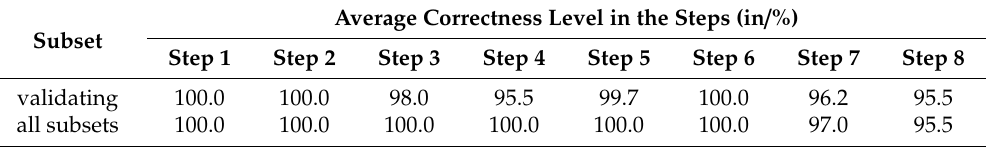
Table 5. Result of step classifications for all subsets summarized from six